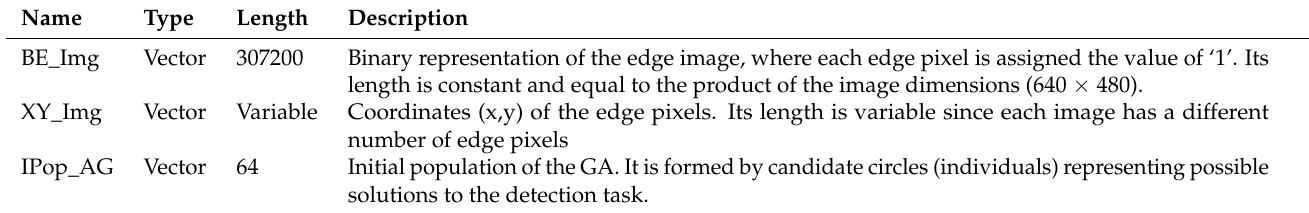
Table 3. Data structure generated in the pre-processing stage and used as input to the circle detection